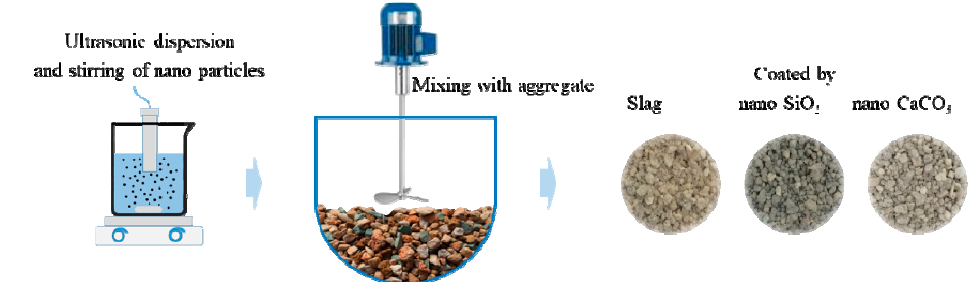
Figure 3. Schematic of aggregate coating process.